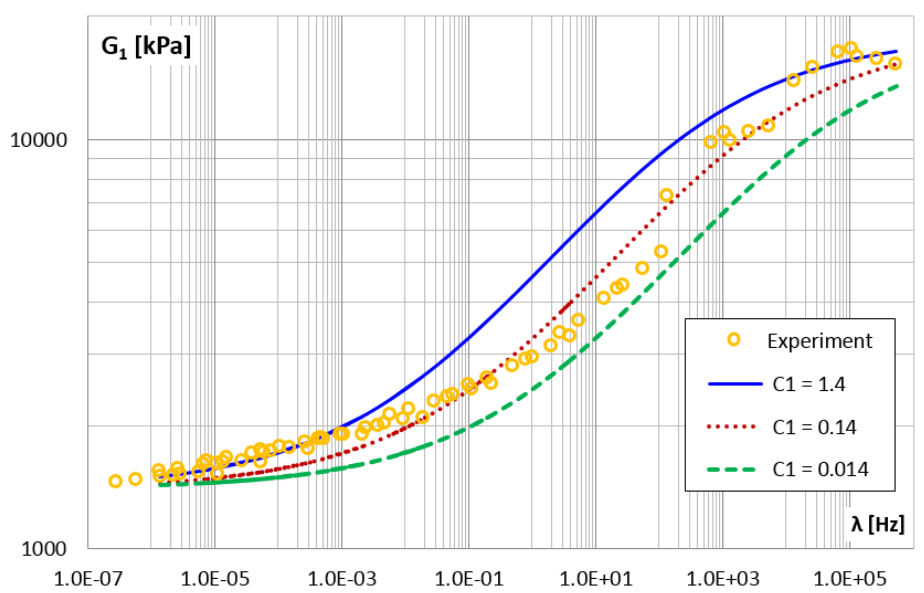
Figure 24. The shear storage modulus G 1 vs. frequency for different values of parameter c 1 .